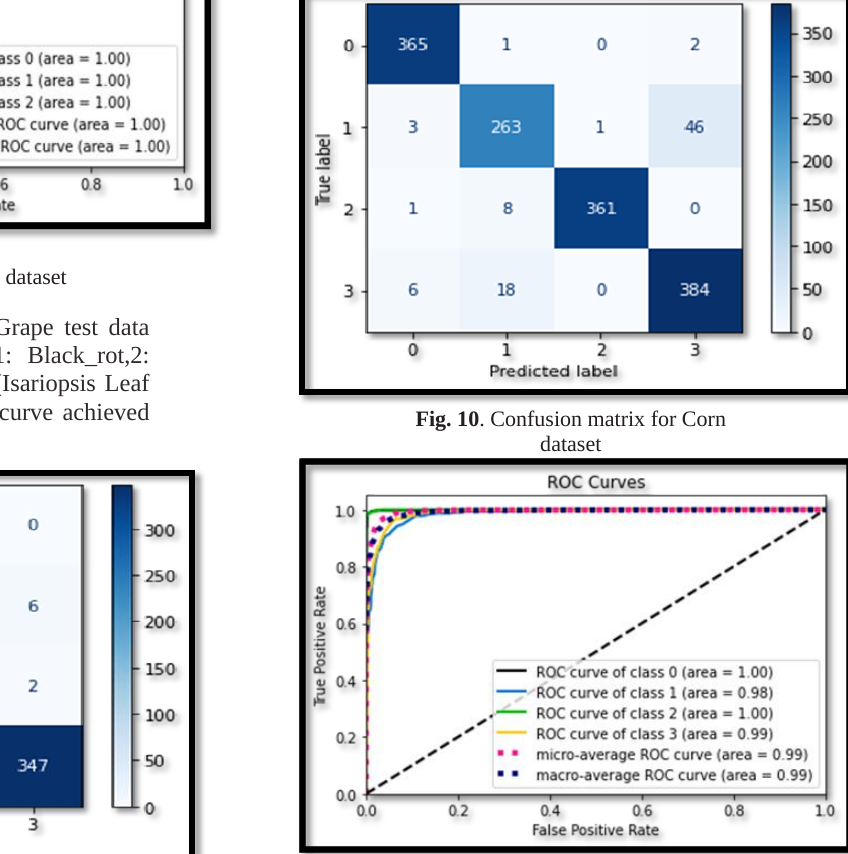
Fig. 11. ROC Curve for Corn